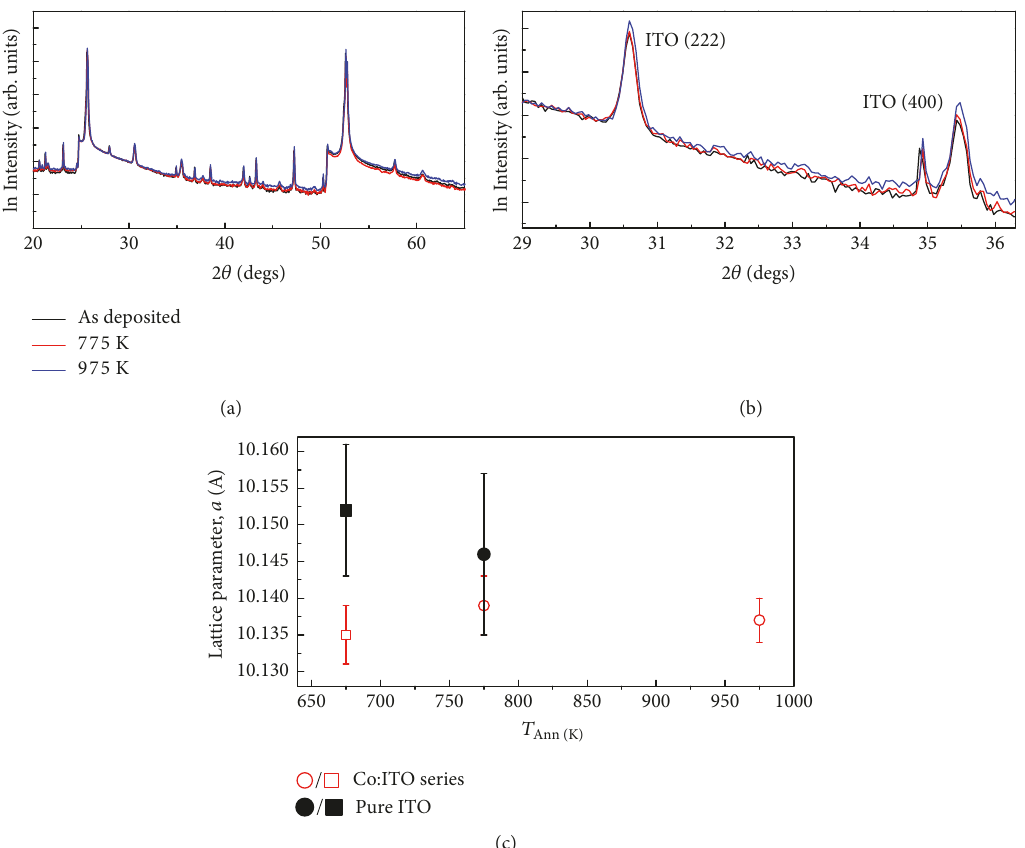
Figure 1: (a) 𝜃 -2 𝜃 XRD diffractograms of the as-deposited (solid black line) and annealed films (red and blue solid lines); (b) an expanded view of the same 𝜃 -2 𝜃 XRD diffractograms shown in (a) but focus is now put on the ITO (222) and ITO (400) peaks demonstrating the shift in the peak positions as the annealing temperature is increased to 975 K; (c) out-of-plane lattice parameter for as-deposited (squares) and annealed (circles) pure ITO (black) and Co-doped ITO (red) thin